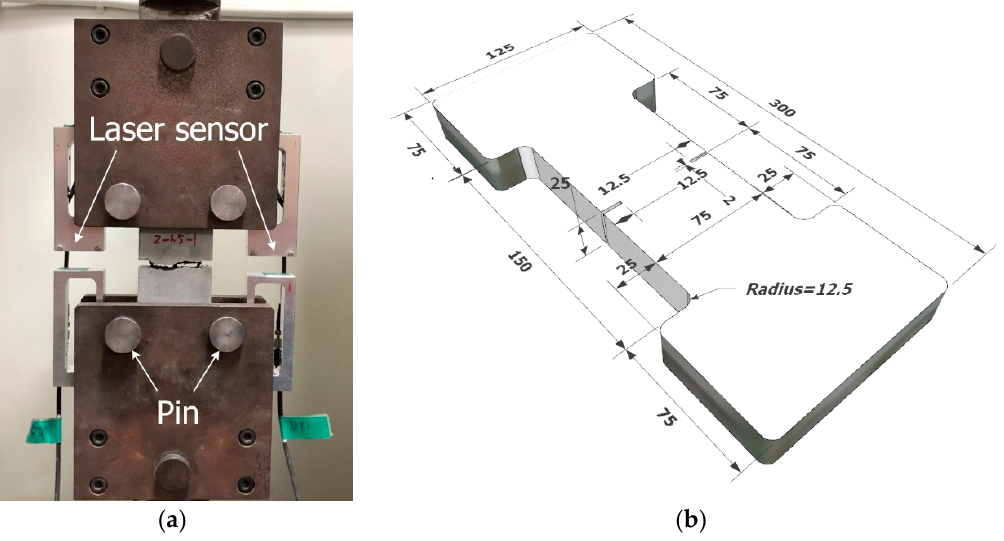
Figure 2. Schematic of direct tensile test. ( a ) Test set-up; ( b ) Dimensions of coupon specimen (units, mm). Table 4. Summary of the results for direct tension tests (average values of ten